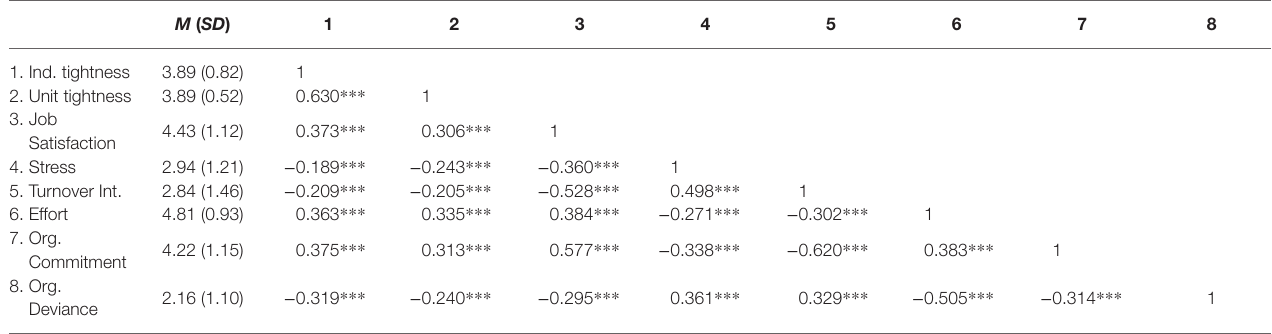
TABLE 1 | Descriptive statistics and variable intercorrelations.